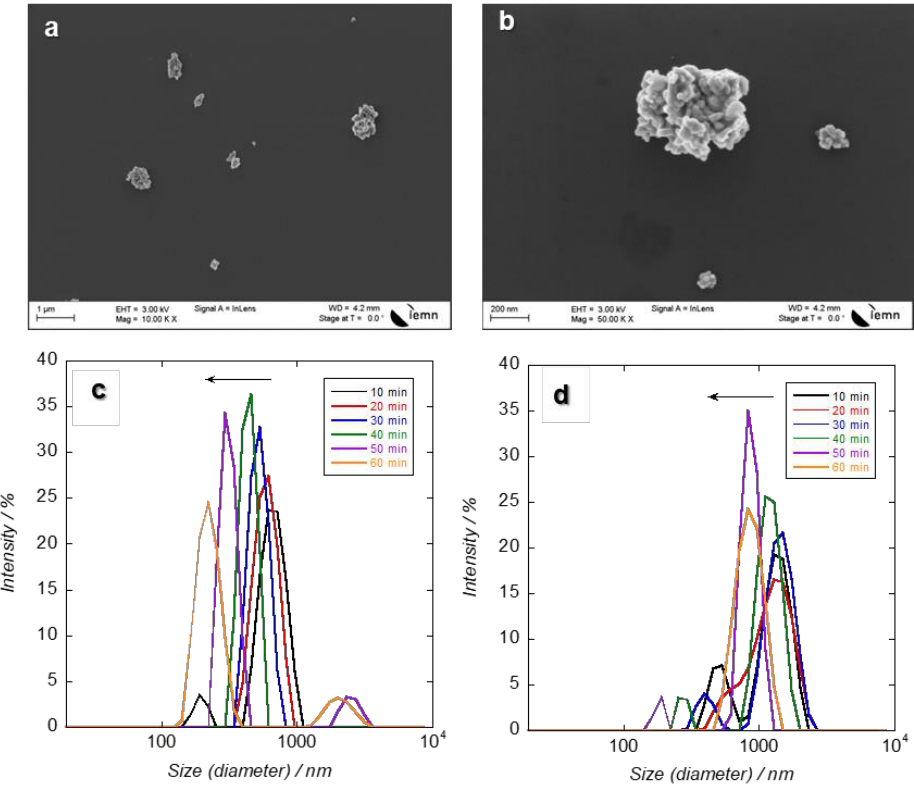
Figure 2. Scanning Electron Microscopy (SEM) images of ( a ) 50 nm and ( b ) 100 nm Ag NPs. Hydrodynamic diameter of ( c ) 50 nm and ( d ) 100 nm Ag NPs in seawater (28 PSU) at 200 mg L −1 during 1 h.